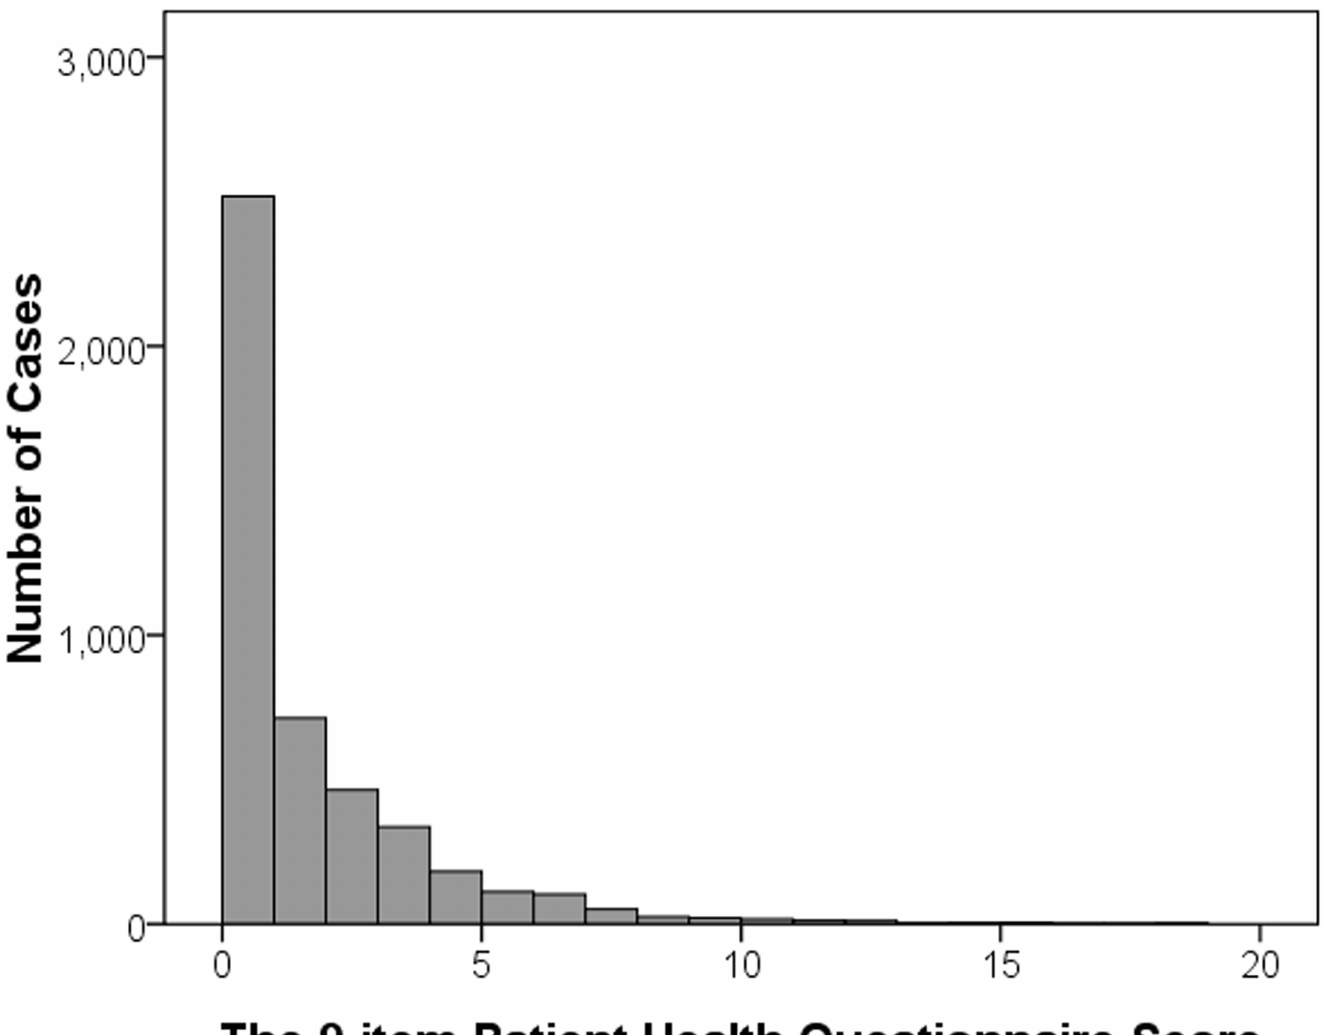
Fig 1. Distribution of PHQ-9